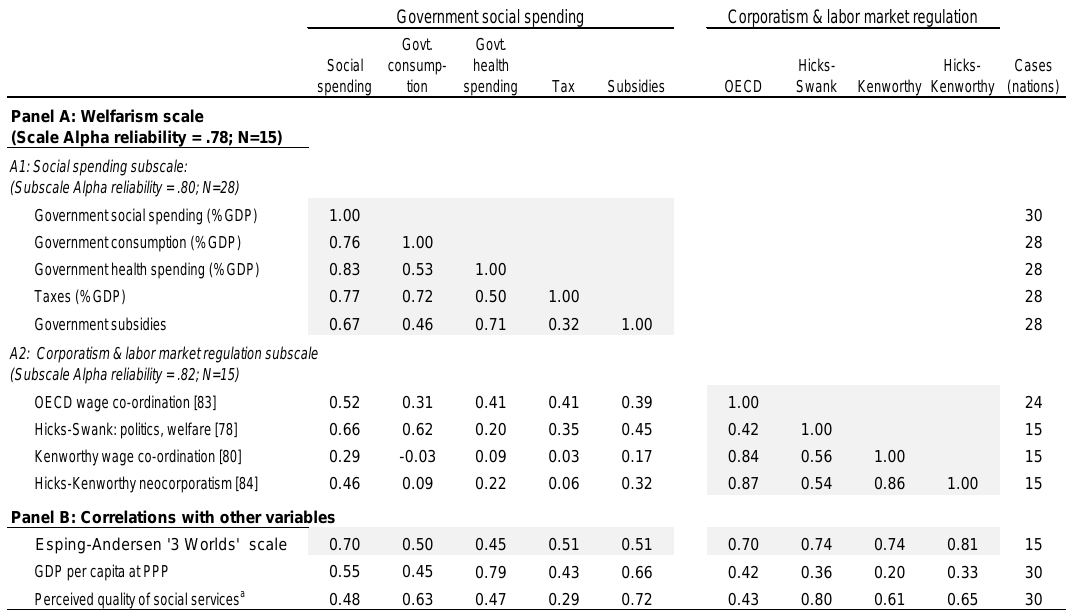
Panel B: Correlations with other variables Esping-Andersen '3 Worlds' scale